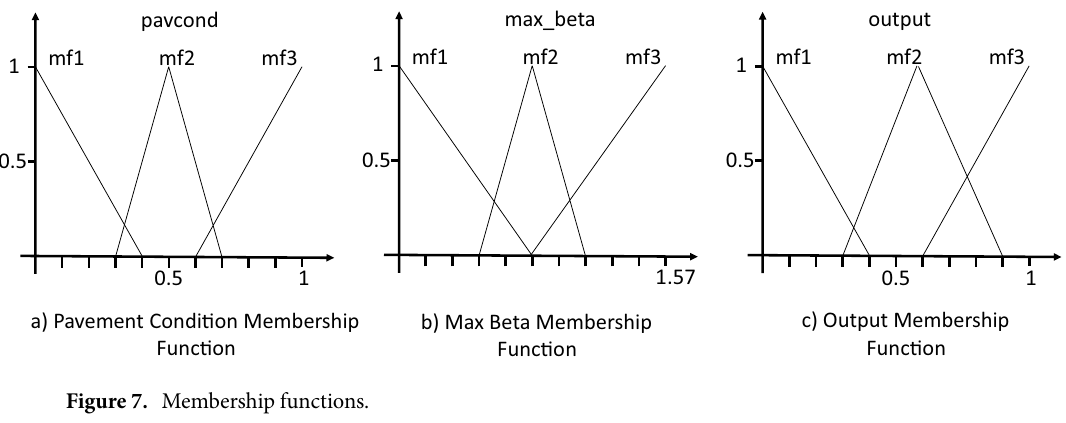
Figure 7. Membership